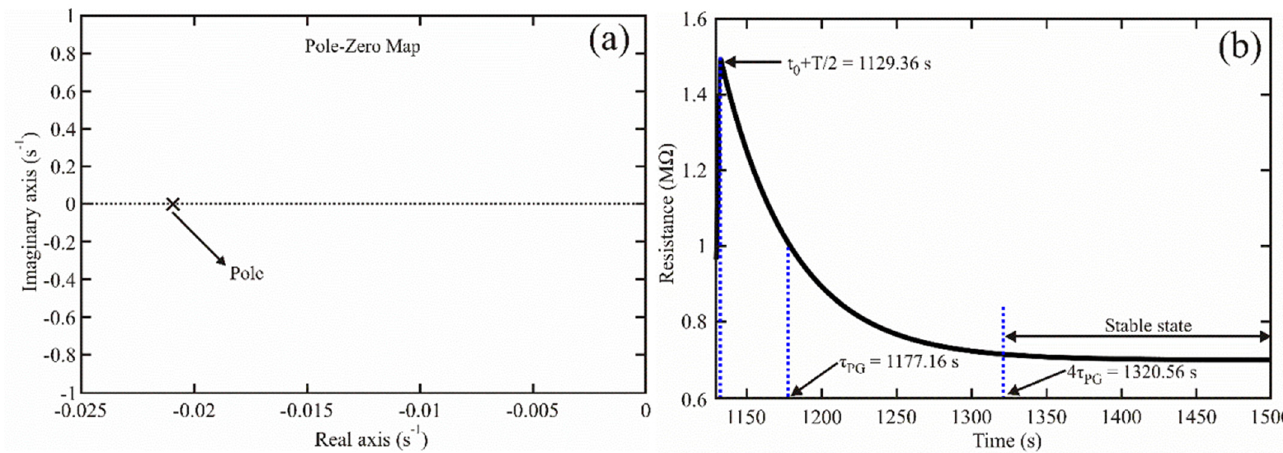
Figure 4. ( a ) Pole-zero map obtained for the chemical sensor based on the ZnAl 2 O 4 oxide; ( b ) Establishment time measured for our chemical sensor.